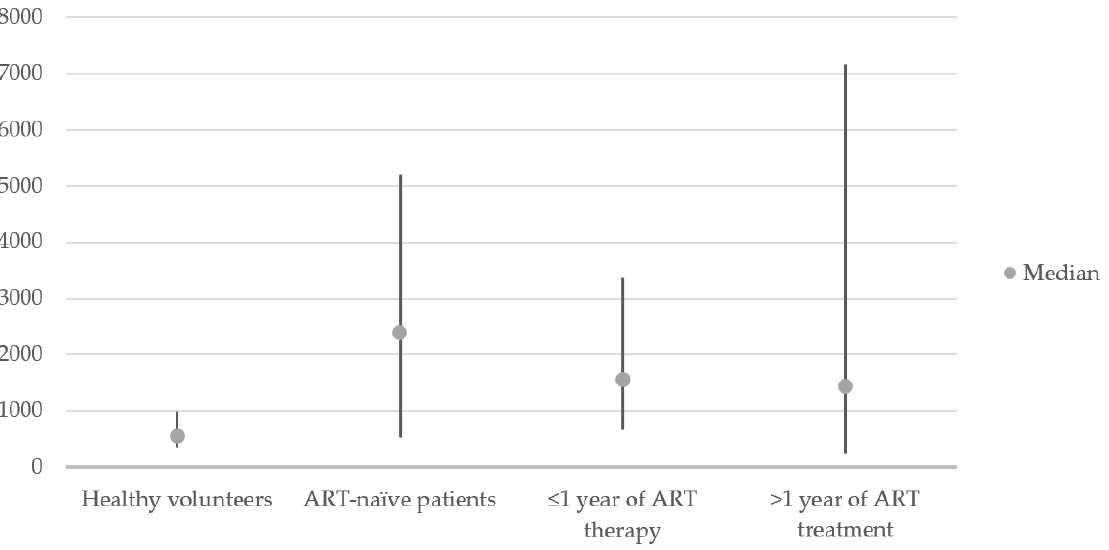
Figure 1. Distribution of VCAM-1 concentrations in healthy volunteers and examined groups of patients.